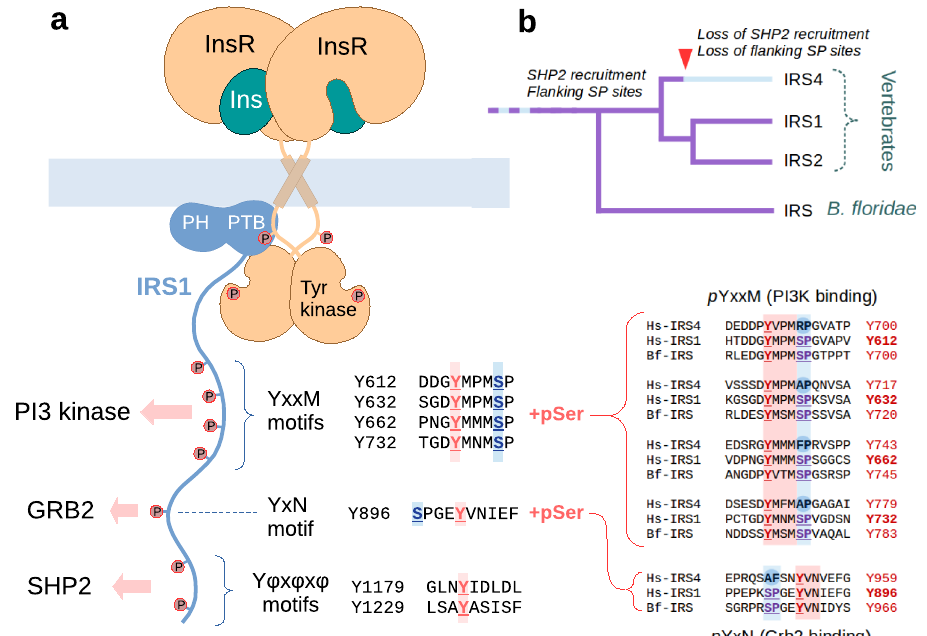
b Evolutionaryanalysesshowingthat fl ankingserinephosphorylationsiteshaveco- evolvedwithSHP2recruitmentandwereconcomitantlylostonthevertebrateIRS4 lineage. Conservation of all fi ve sites in the single Branchiostoma fl oridae